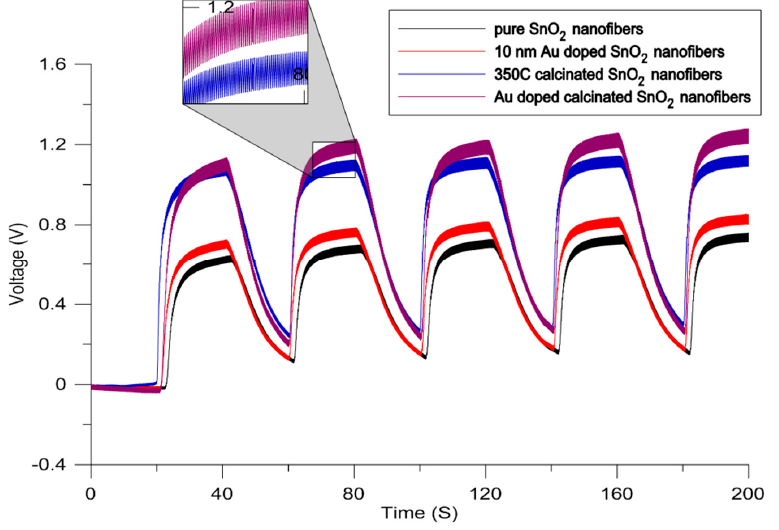
Figure 4. Effects of calcination, doping, and calcination ‐ doping on the response of the sensor to 1000 ppm of methanol.